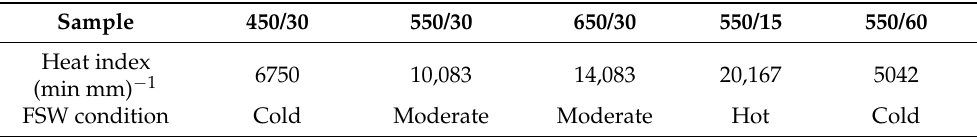
Figure 4. The cross-sections of the ( a ) 450/30, ( b ) 550/30, ( c ) 650/30, ( d ) 550/15, and ( e ) 550/60 samples observed with OM (yellow dotted line: the initial Al/steel interface, red arrows: the Al/steel interface after FSW). Table 2. The results of the heat index calculated in this